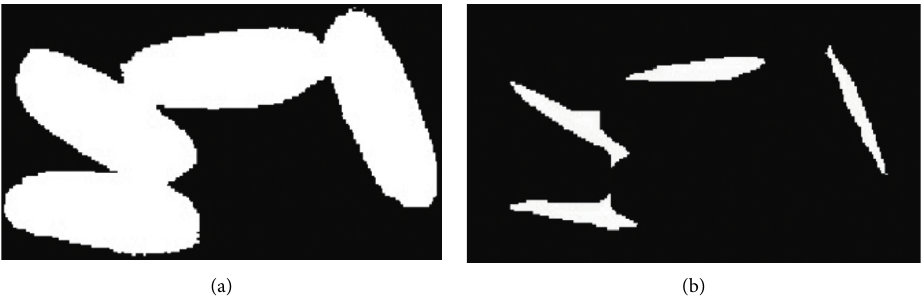
Figure 8: Baseline endpoint matching diagram. (a) The binary image. (b) The obtained seed